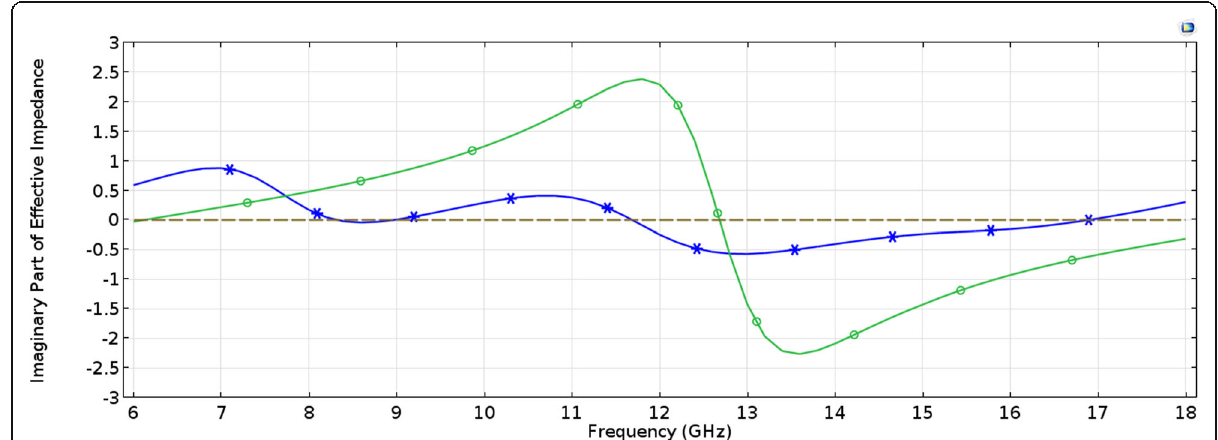
Fig. 13 Calculated imaginary effective impedance plots of metastructure absorber and flat